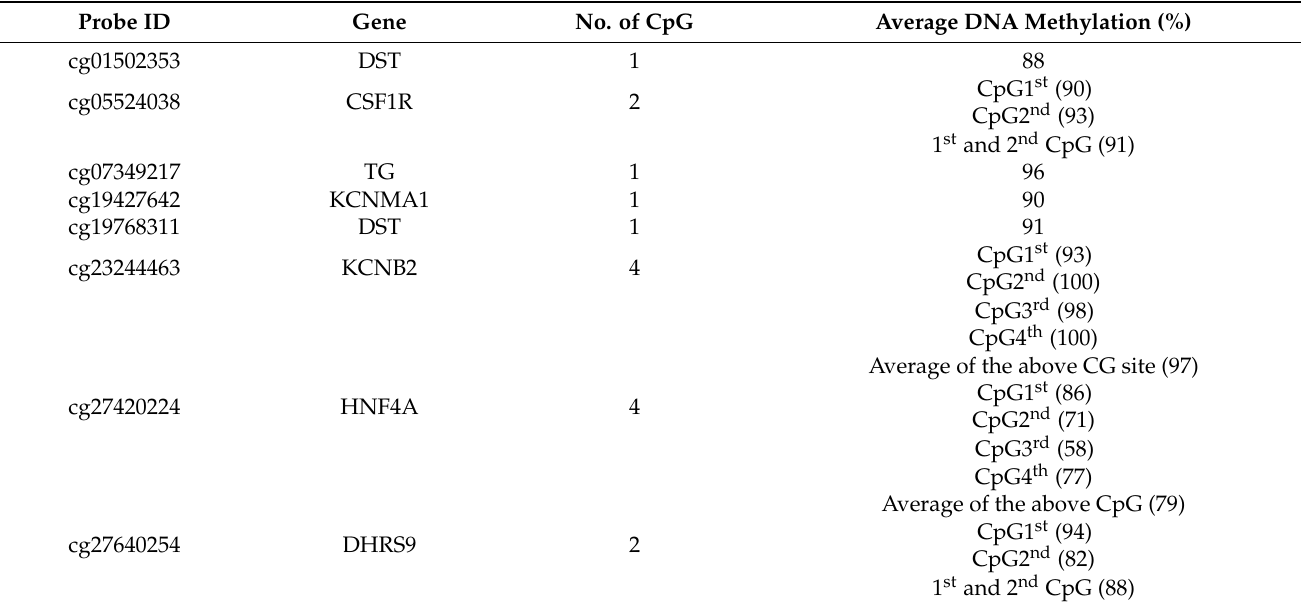
Table 3. DNA methylation percentage of 8 CpGs in cord blood samples ( n = 82) validated by q-PCR.